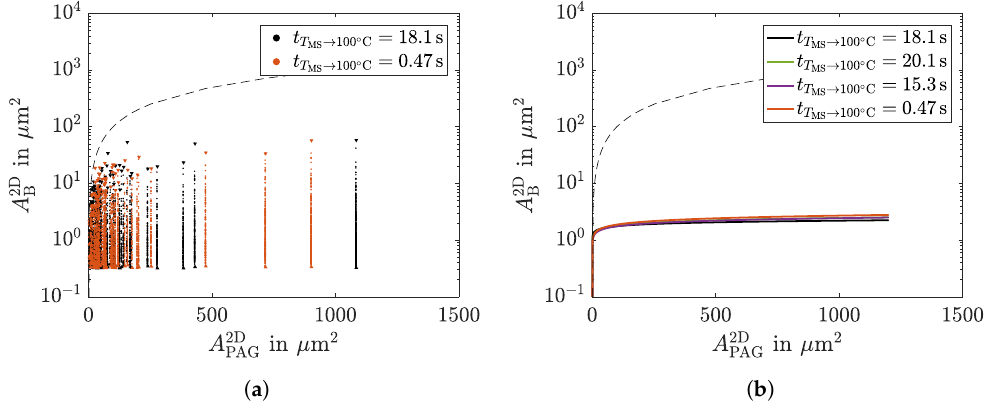
Figure 9. Martensite block cross-section area depending on the prior austenite grain (PAG) cross-section area: ( a ) measured data, ( b ) representation of measured data with fitted